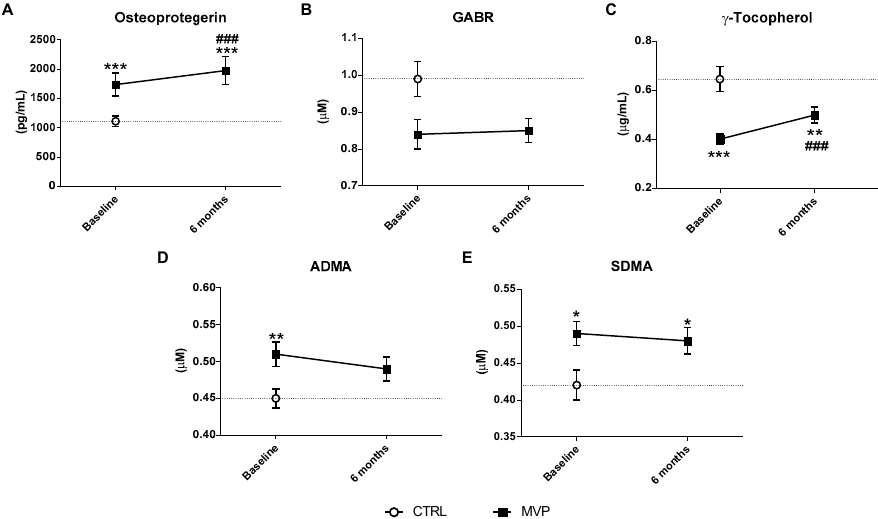
Figure 2. Endothelial function assessment. Plasma levels of ( A ) osteoprotegerin (OPG), ( B ) the index of global L-arginine bioavailability (GABR), ( C ) γ -tocopherol, ( D ) asymmetric (ADMA), and ( E ) symmetric (SDMA) dimethylarginines. All the analyses were performed in mitral valve prolapse (MVP) patients ( n = 45) before and 6 months after surgery and in controls (CTRL, n = 29). Data are reported as mean ± 95% confidential interval. *** p ≤ 0.001, ** p ≤ 0.01, and * p ≤ 0.05 vs. CTRL; ### p ≤ 0.001 vs. MVP at baseline.